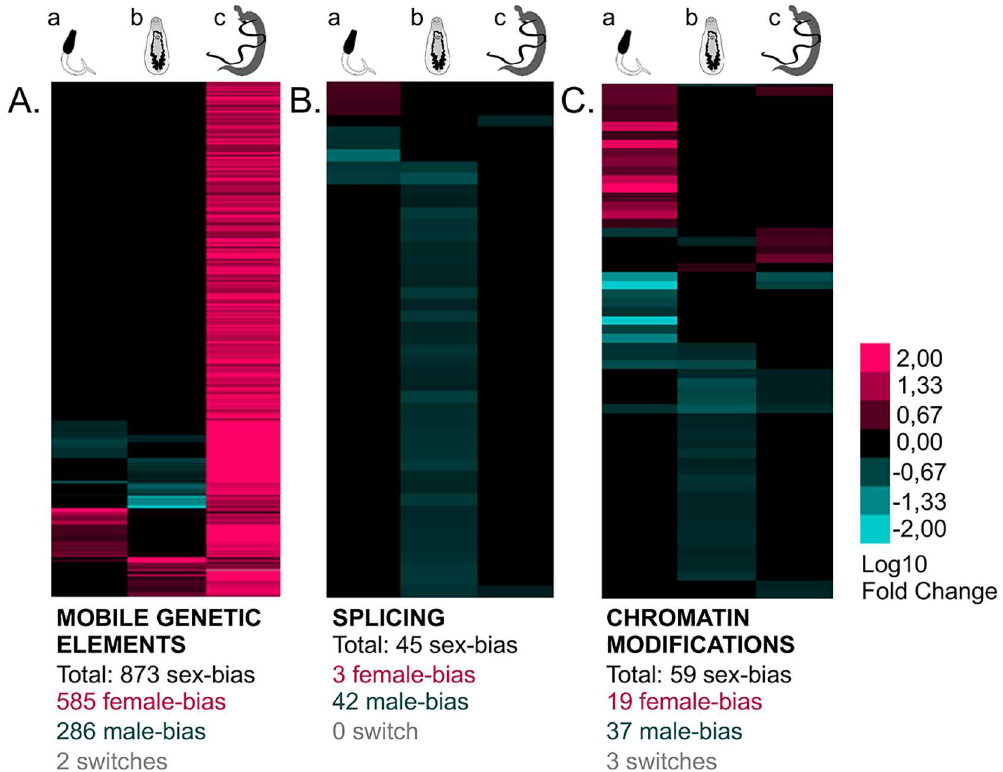
Fig 6. General clustering of sex-biased gene expression depending on their “regulation of gene expression” functional category. male-biaises are represented in blue, female-biaises in pink and non- significant differences (Padj > 0.05) in black. Three stages are considered: (a) cercariae, (b) schistosomula s#2 and (c) adults. (A) 873 mobile genetic elements were detected as sex-biased, mainly in female adult worms. (B) 45 splicing-linked genes are mainly male-biasedin schistosomula s#2. (C) 59 genes involvedin chromatin modificationare mainly male-biased in schistosomula s#2. The functional annotationand details on gene expression are provided in S6